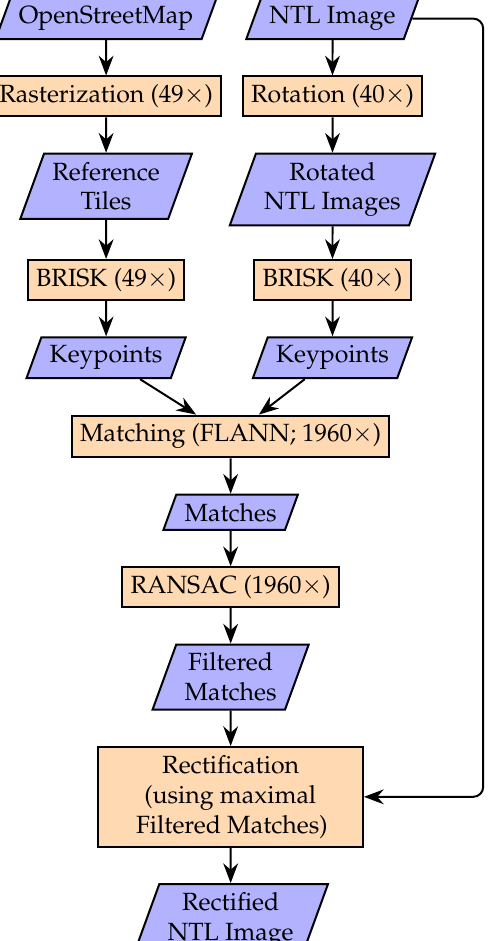
Figure 2. Proposed matching and rectification algorithm for NTL